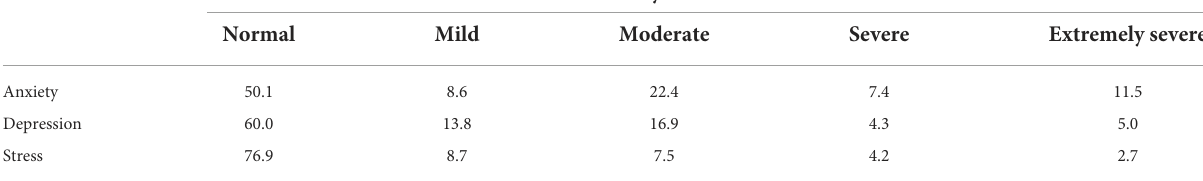
TABLE 3 Percentage of students at each level of clinical severity on the three measures of mental distress.